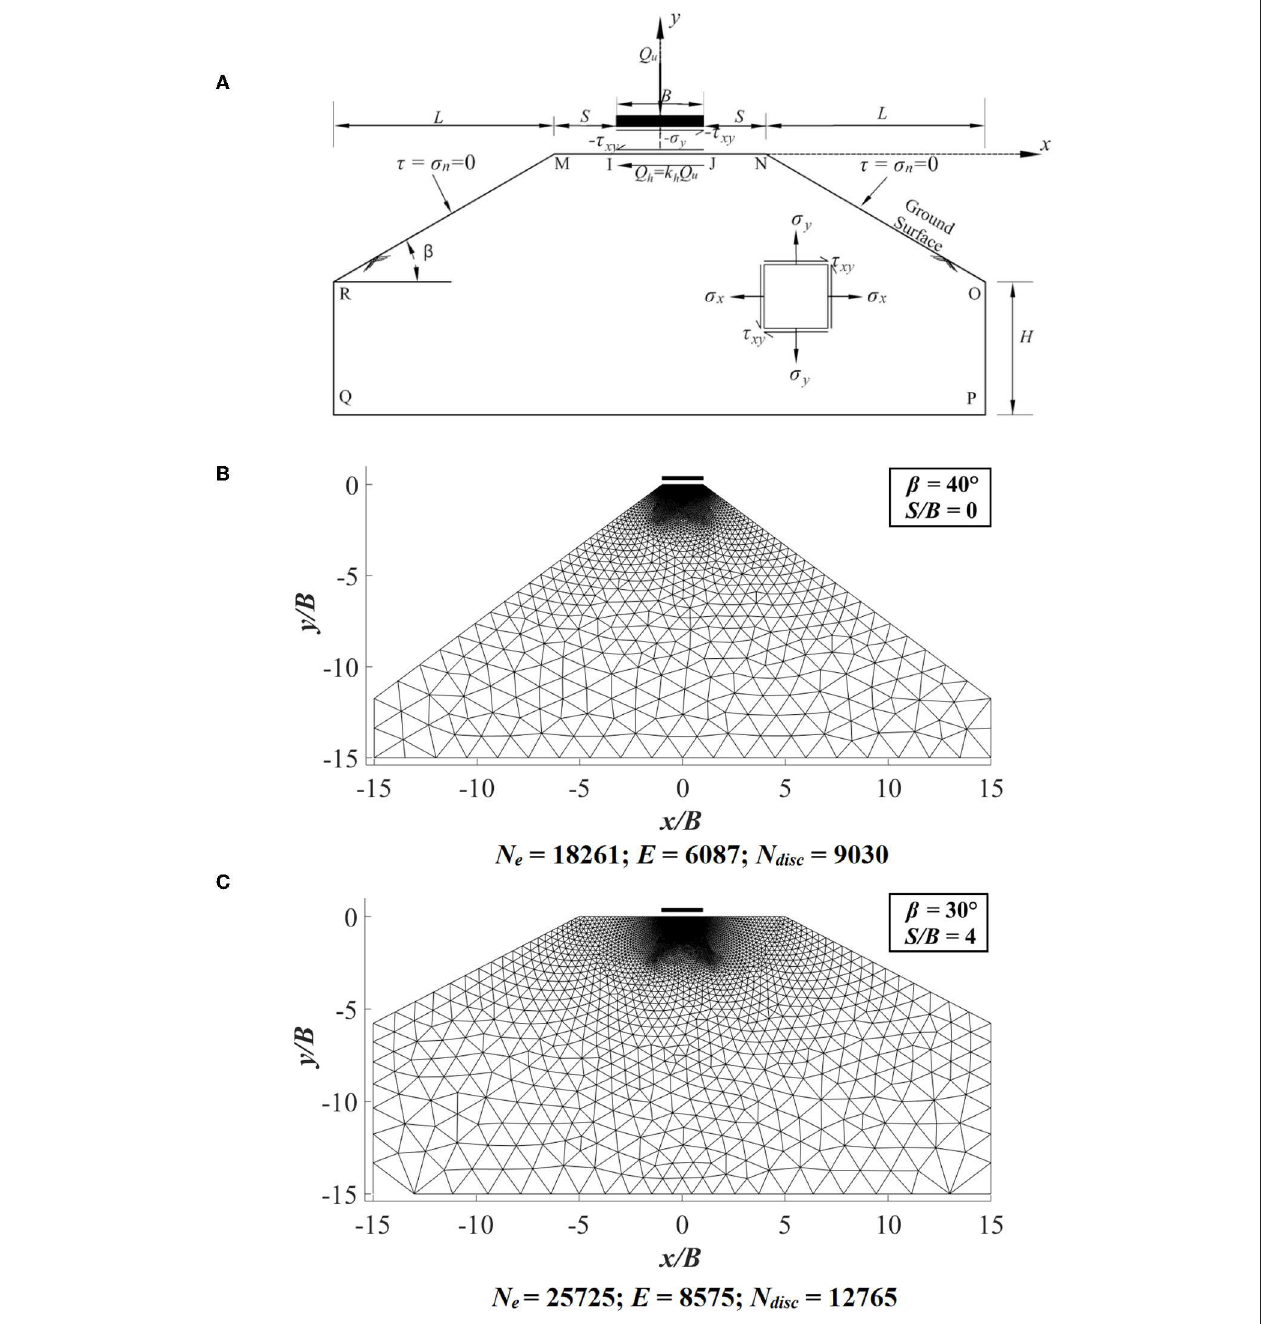
FIGURE 1 | (A) Problem domain with stress boundary conditions; (B) finite-element mesh for S/B